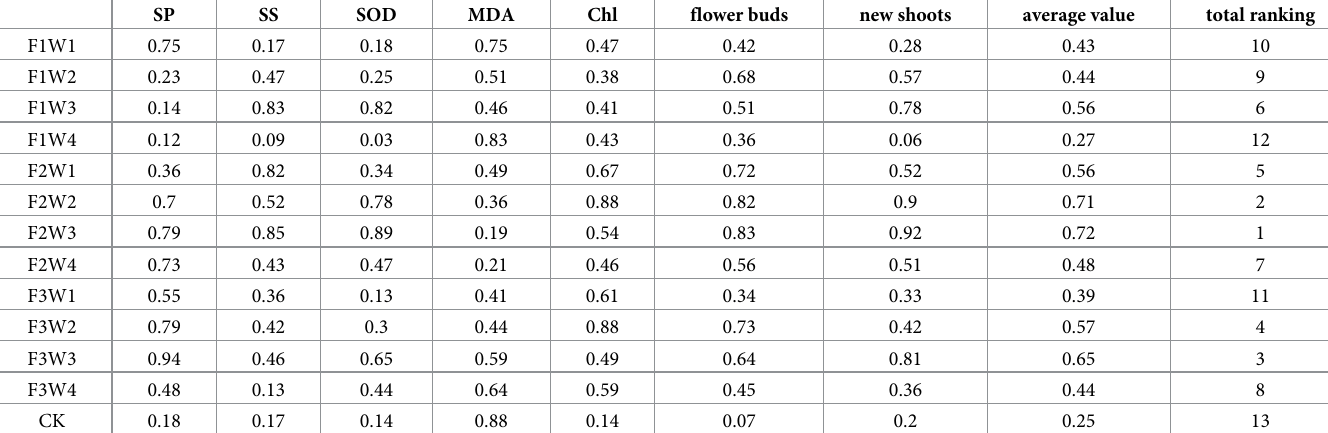
Table 5. Membership values and comprehensive